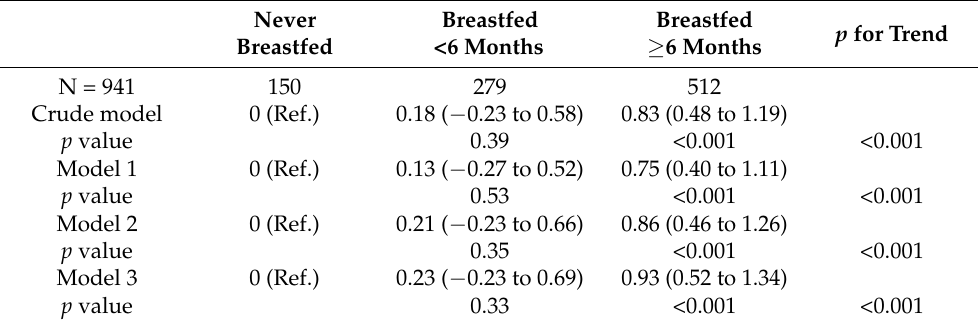
Table 2. Mean difference and 95% confidence interval (CI) in the KIDMED score by breastfeeding history. The SENDO project.